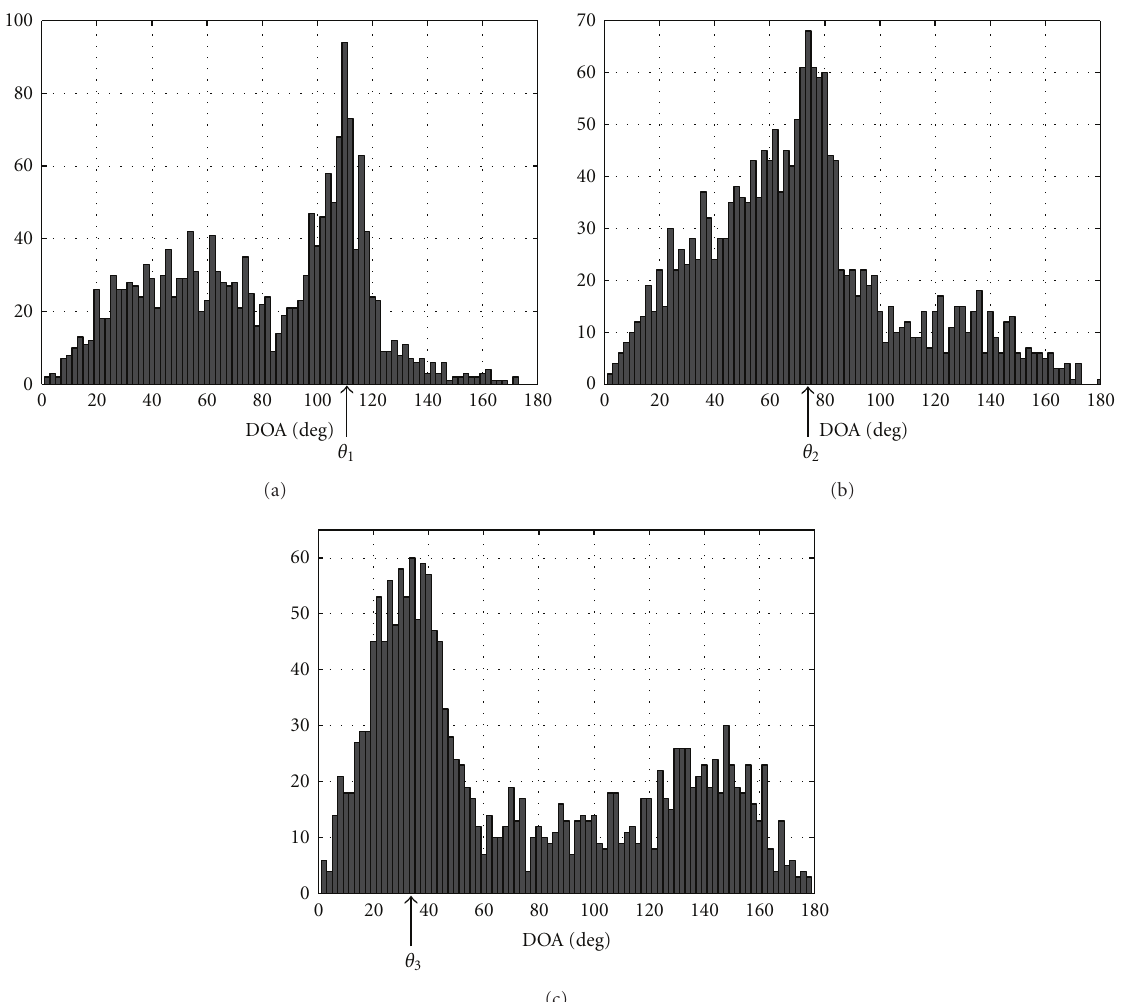
Figure 4: Histogram of the estimated DOAs via ICA from the original mixtures (a), from mixtures after the source from θ 1 was masked (b), and from mixtures after the sources from both θ 1 and θ 2 were masked (c).